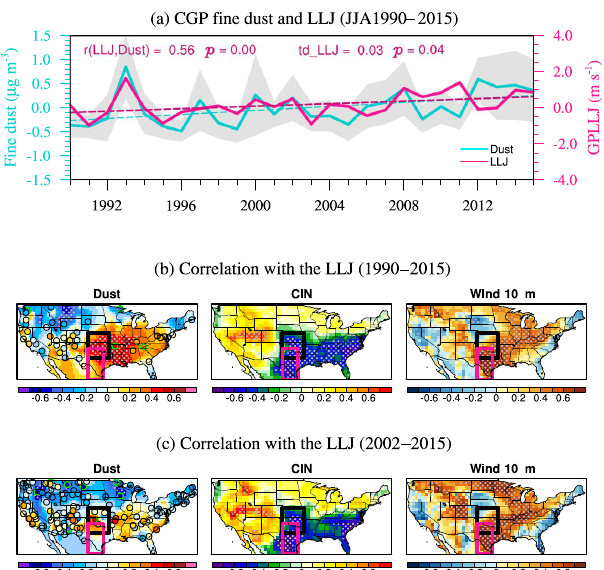
Figure 5. (a) Time series of fine dust concentration (µgm − 3 ) av- eraged in the CGP (cyan) and the index of the Great Plains low- level jet (magenta) and their trends (dashed line) in JJA from 1990 to 2015. Grey shading denotes ± 1 standard error of the obser- vations. Correlations between the jet index and fine dust concen- tration, CIN, and near-surface wind speed for (b) 1990–2015 and (c) 2002–2015. Colored circles denote correlations at IMPROVE stations, with green outlines denoting that the correlation is sig- nificant at the 90% confidence level. Areas significant at the 95% confidence level are dotted in panel (b) and areas significant at the 90% confidence level are dotted in panel (c) . The black box in pan- els (b–c) denotes the CGP region, and the deep pink box denotes the averaging area for the jet